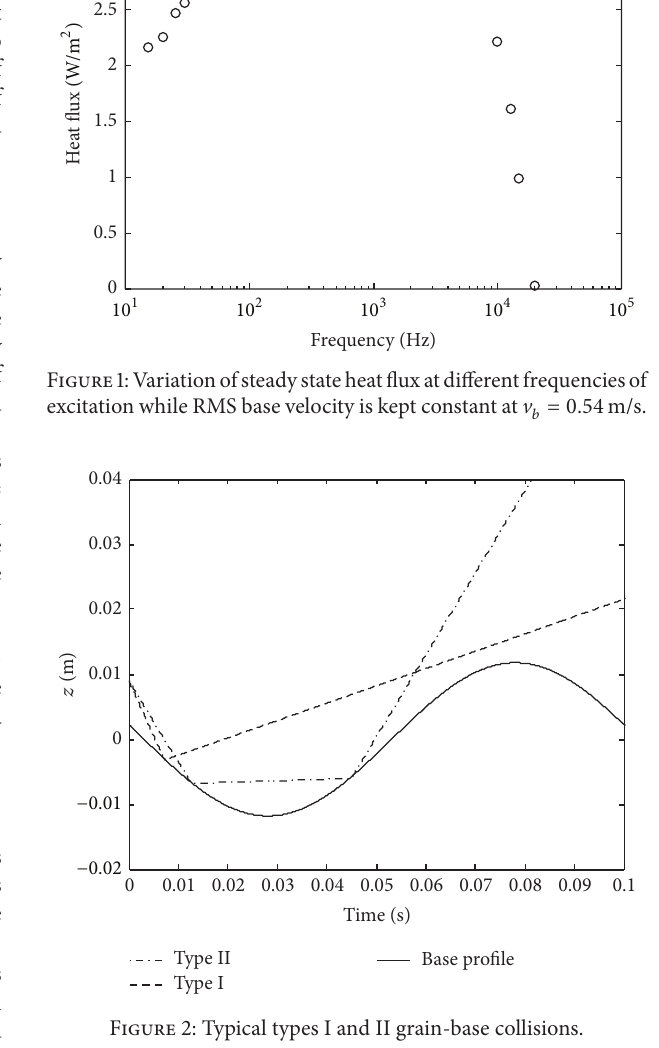
Figure 2: Typical types I and II grain-base